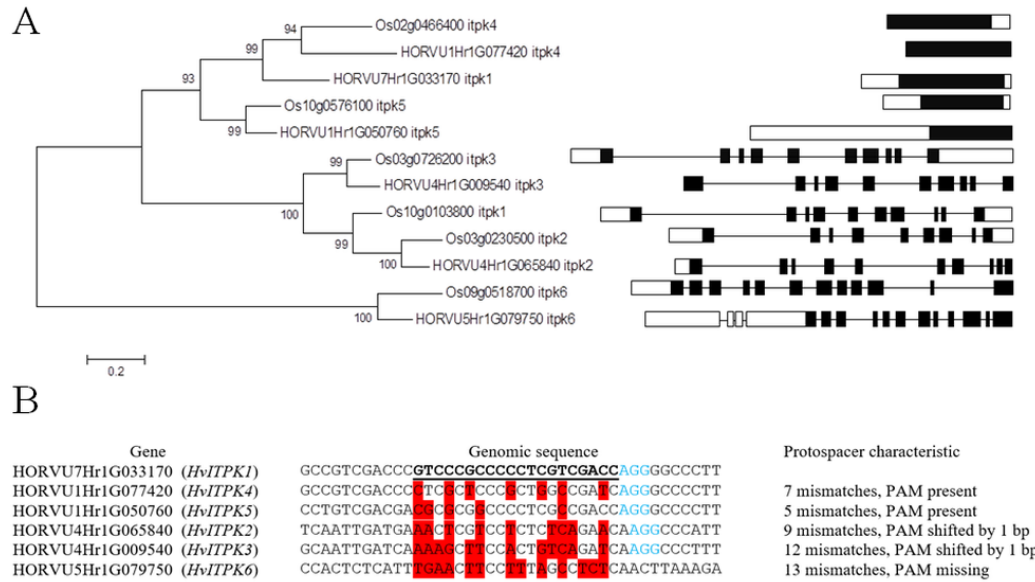
Figure 1. Analysis of barley ITPK genes. ( A ) Phylogenetic tree of barley and rice ITPK proteins. The phylogenetic tree was built using amino acid sequences. The scheme of ITPK genes illustrates exons (black), introns (joining), and untranslated regions (white). ( B ) Alignment of protospacer sequences within barley ITPK genes. Mismatches within the protospacer sequence are highlighted in red, the PAM sequence is shown in blue font.